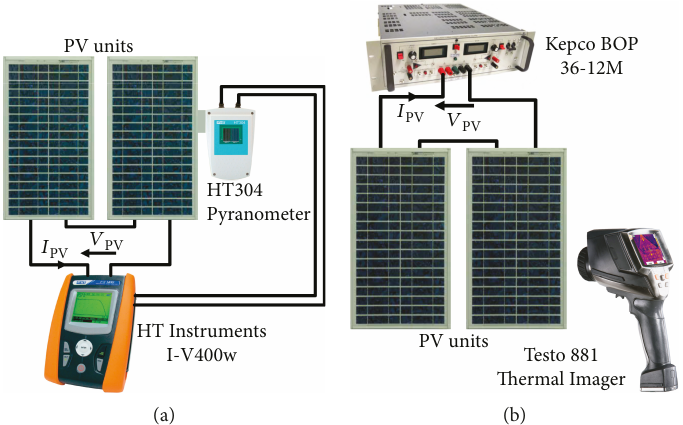
Figure 1: Experimental set-up adopted for (a) tracing I - V and P - V characteristics and (b) measuring PVU temperature as a function of the operating point.